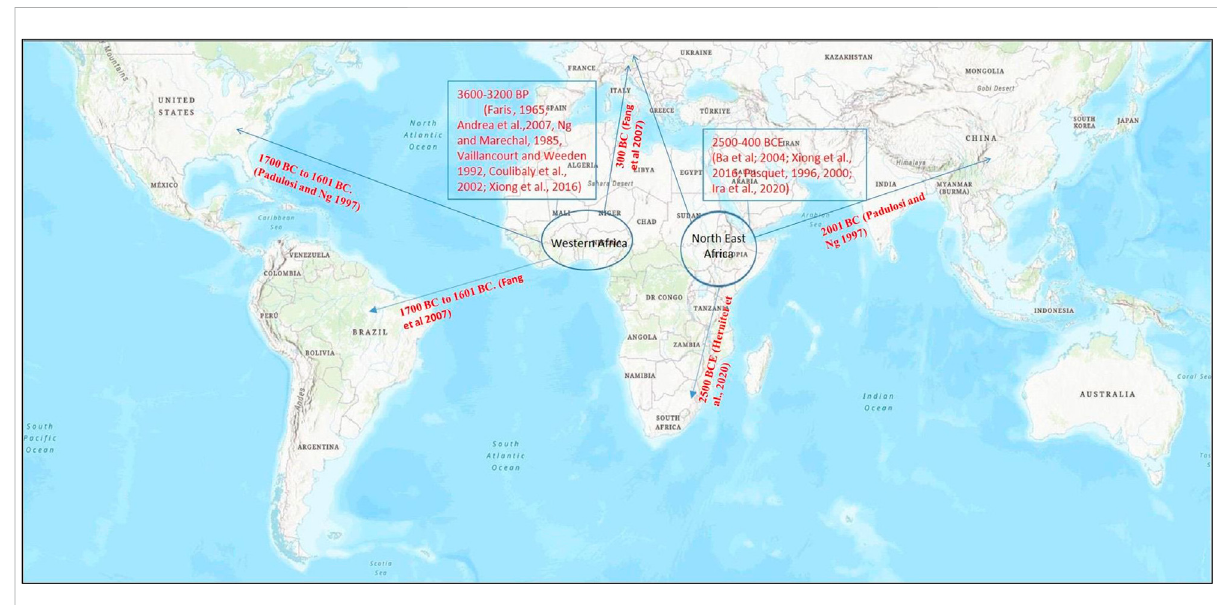
FIGURE 1 Map representing cowpea ( Vigna unguiculata )origin ofdomestication(encircled) andits spread (arrow) to differentparts oftheworldbased on archeological evidences and genetic studies for domestication-related